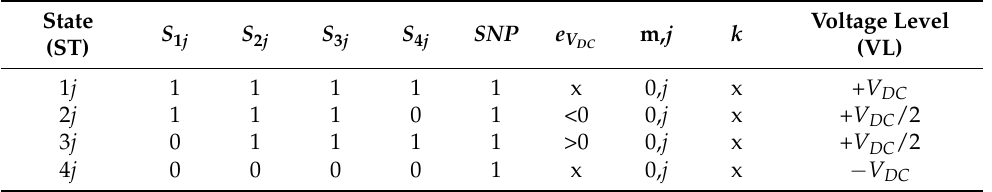
Table 1. Generic voltage levels in normal operation for the j phase.